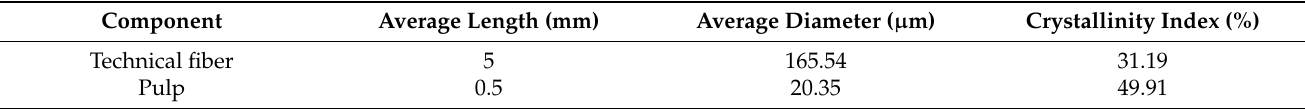
Table 1. Characteristics of the nonwoven